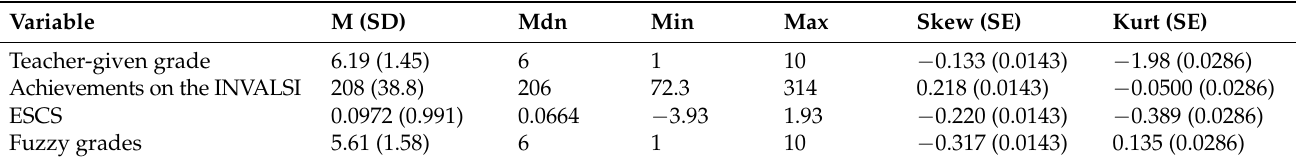
Table 5. The descriptive statistics for the variables.